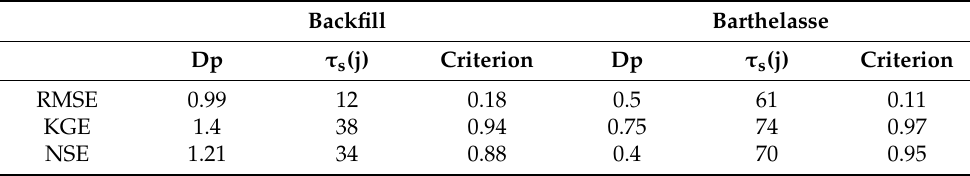
Table 1. Main results of the LPMs applied to the backfill and the pumping field.